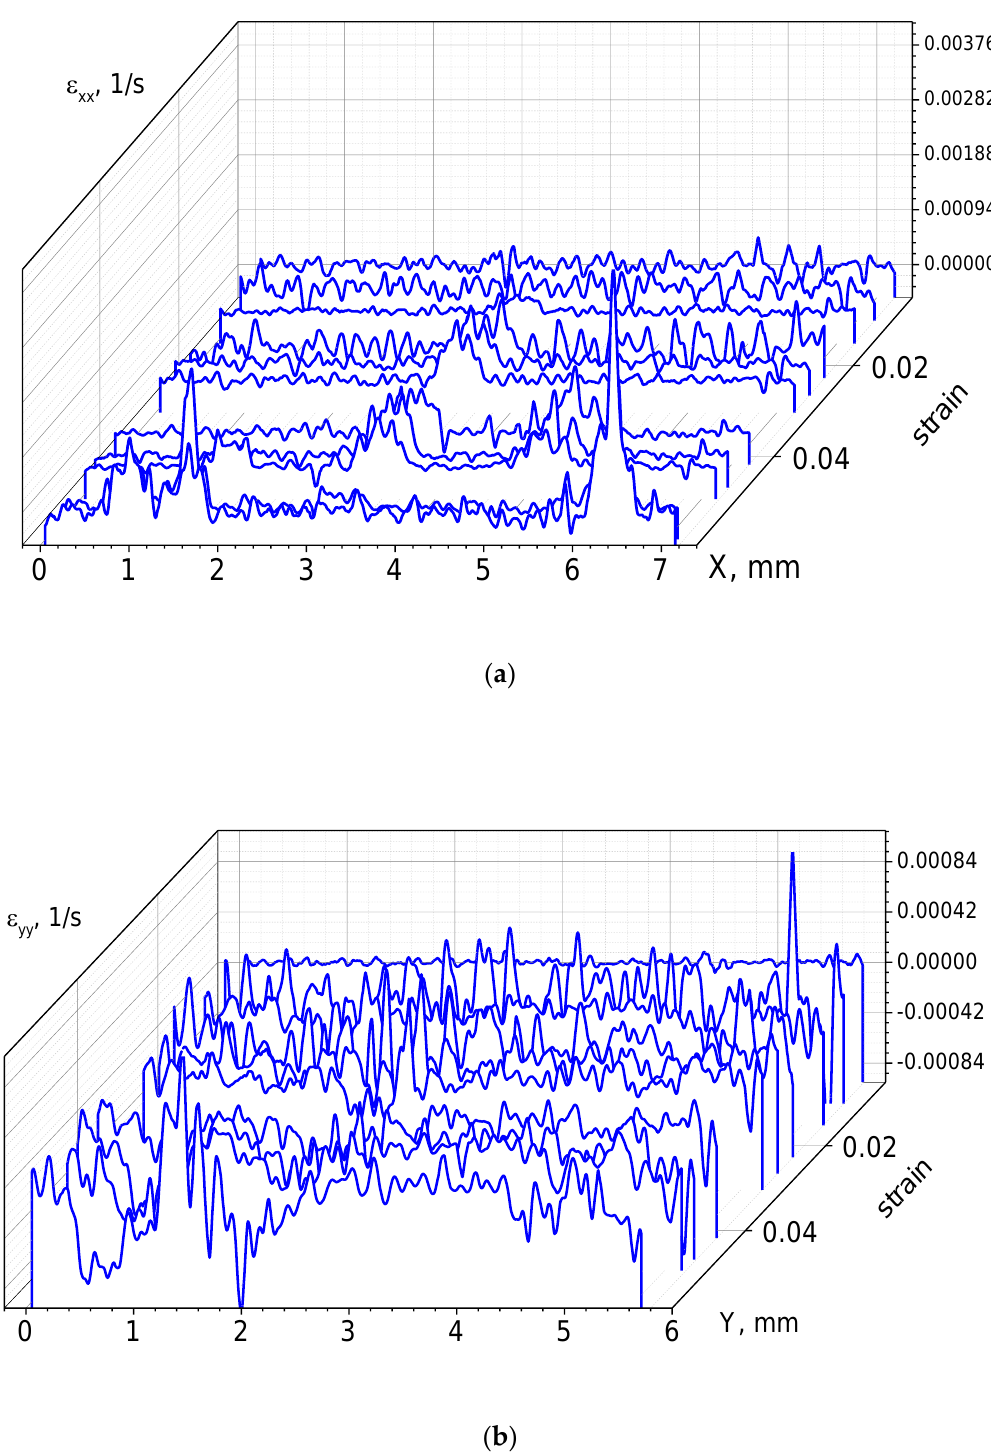
. . ε xx ( X , Y = Y m /2 ) ( a ) and ε yy ( Y , X = X m /2 ) ( b ). Data